Question: What visual encoding does this figure use to show its data?
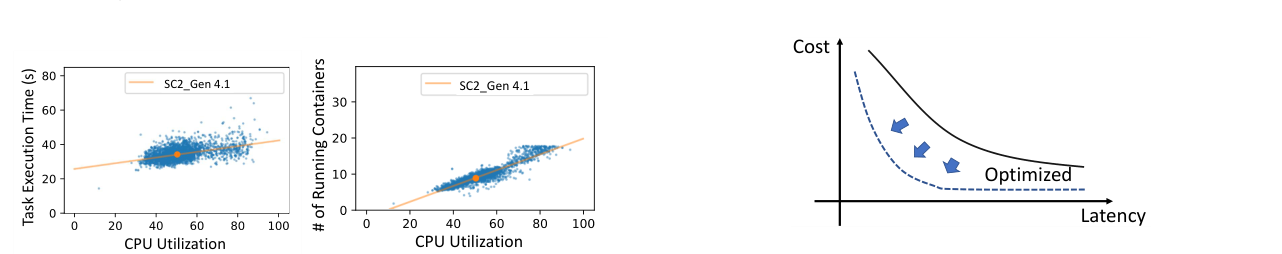
Answer: line